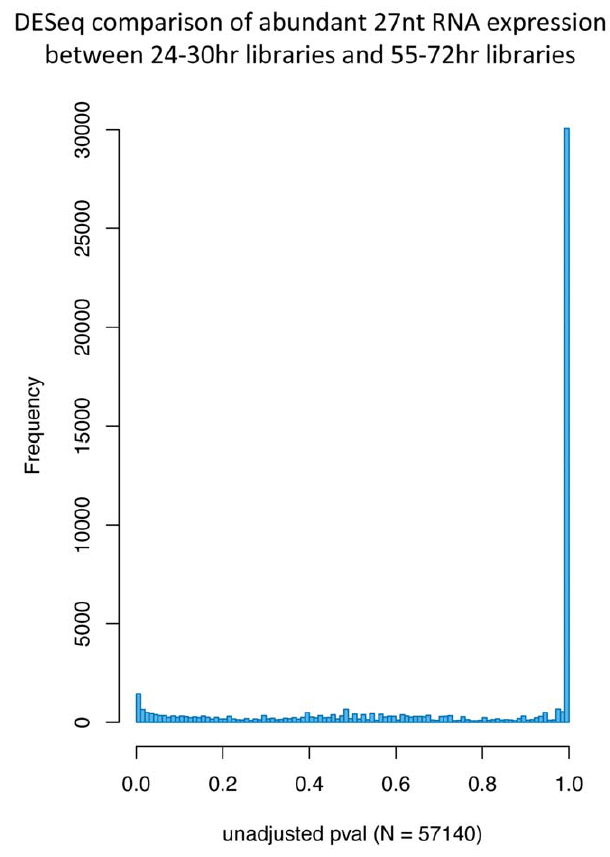
Figure 7. Histogram of unadjusted p-values for changes in relative expression level for 27 mers between early and late mating libraries. DESeq [35] was used to compare relative expression levels of distinct 27 mers whose sequence was found 10 or more times in any of the mating libraries. The relative expression of each of 57,140 abundant 27 mers between early mating time points (mat24_05, mat24_06 and mat30_07) and later mating time points (mat55_10 and mat72_11) was compared. Unadjusted p-values for changes in expression for each of the 27 mers were plotted on the histogram. positions from the 5 9 or 3 9 end of the nanochromosome, for both the plus strand or minus strand-aligning reads. These distributions were plotted relative to a plot of uniform distribution based on the average coverage over the 500 positions at the appropriate end of the nanochromosome (Figure 11). The telomere repeat in the nanochromosome sequences in the chr1 collection is on average 20 nt, and is indicated by a dashed vertical line in the figure. As small RNA sequences made up of the telomeric repeat would have been filtered out as part of the initial non-coding RNA filter step, we expect to have no coverage in this region. It should be noted that only 237 reads out of 10,570,000 total sequences applied to the non-coding RNA filter in the mat24_06 library matched the telomeric repeat, so the non-coding RNA filter step cannot explain the paucity of coverage of small RNAs at the telomere and subtelomeric regions. Since the counts of the 5 9 ends of the RNAs were plotted, a shaded region 27 nt long was added to the plot for the plus strand reads measured from the 3 9 end of the nanochromosome to account for the 27 nt read length. When these data are plotted, it is clear that there is a zone of 30 nt proximal to the telomere that has over 8-fold lower density of 27 nt RNA coverage relative to a uniform distribution. We did